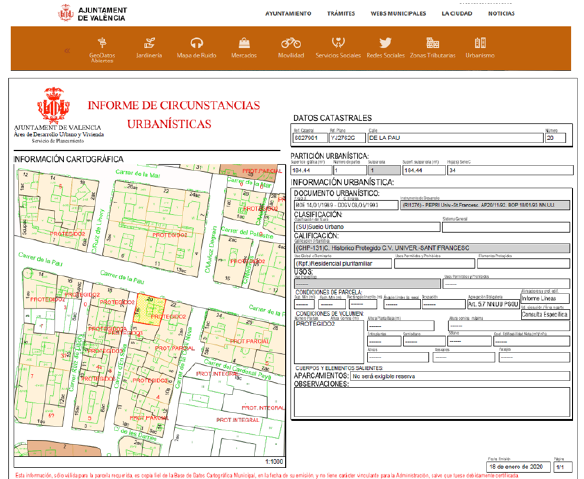
Figure 7. Urban information of a building provided by the Urban Planning Service on the Valencia City Council.